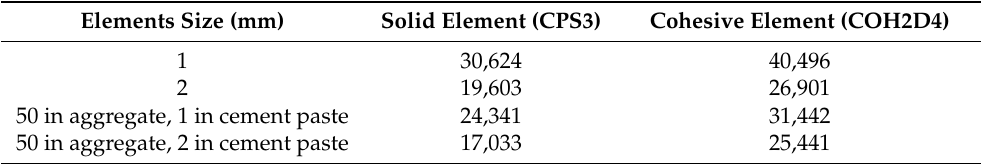
Table 5. The number of solid elements (CPS3) and cohesive elements (COH2D4).